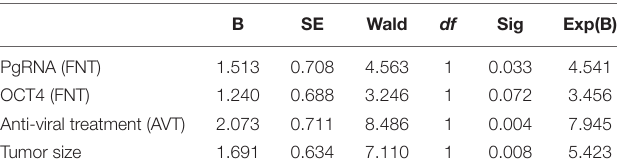
TABLE 4 | Variables in the equation of multivariate cox regression analysis for